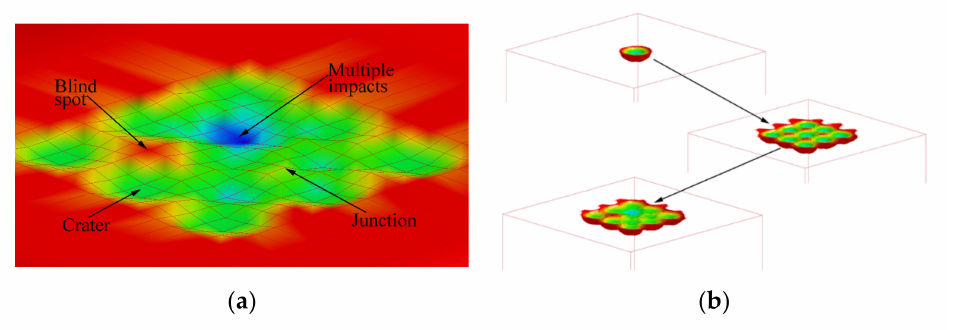
Figure 3. ( a ) Stress contour; ( b ) Impact